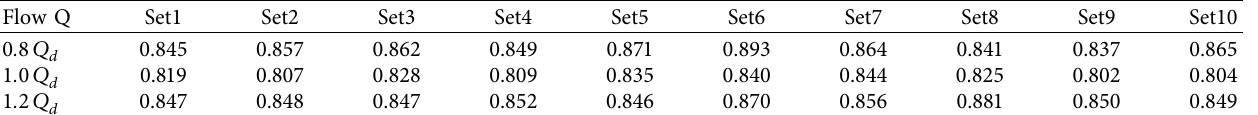
Table 7: Verification